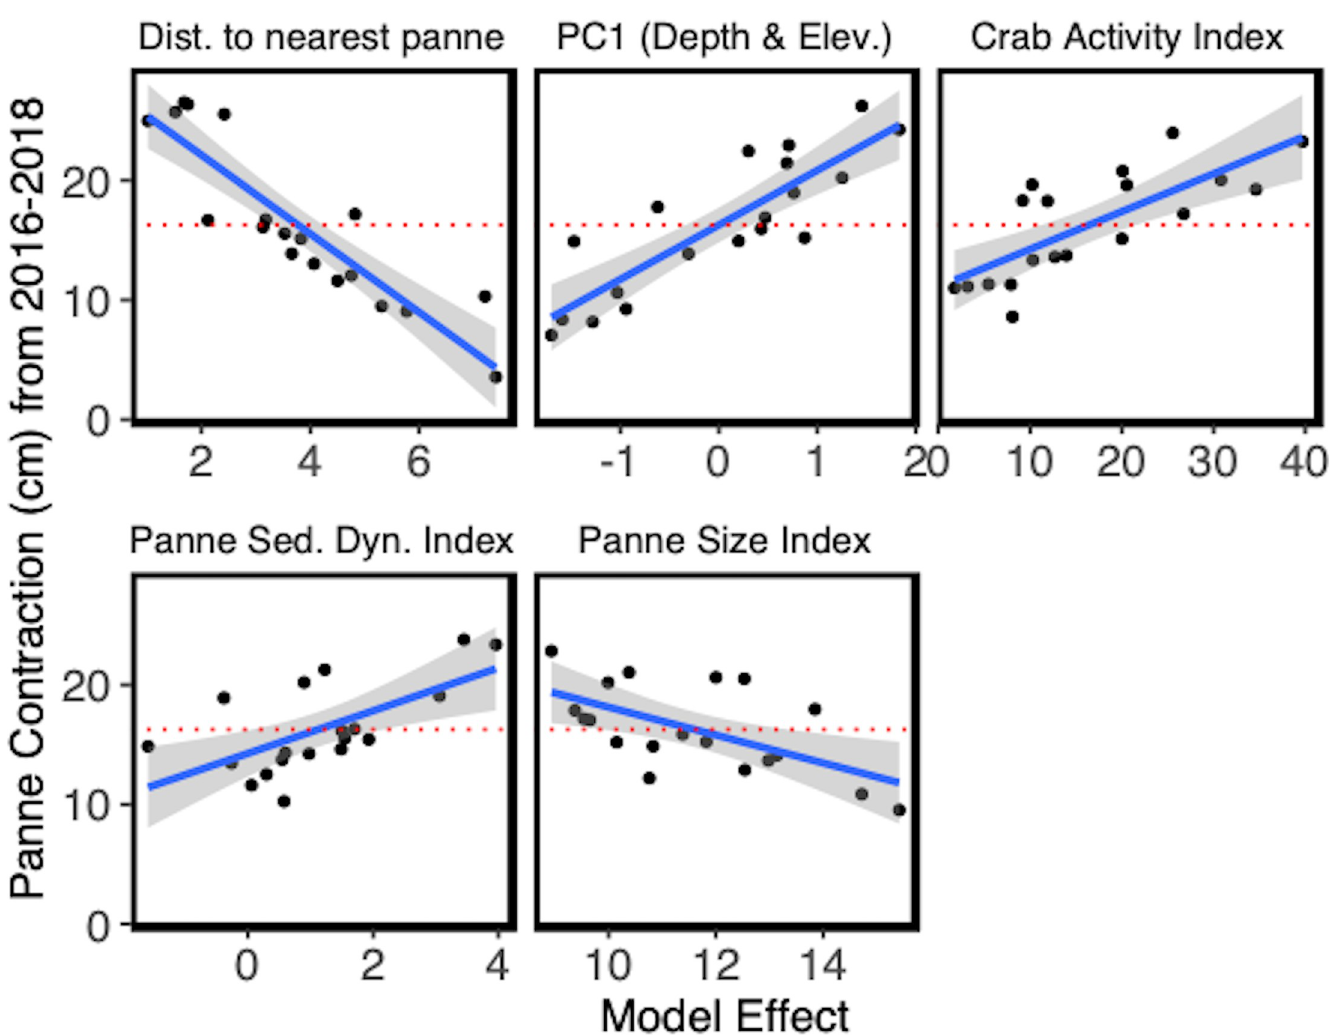
Fig 2. Partial leverage plots for all of the best-fit model effects. Plotted is the movement of marsh into the panne area (panne contraction along marsh-panne boundary) in cm. The dotted red horizontal line represents the average marsh-panne boundary movement from 2016–2018 of 16.298 cm. Each partial leverage plot includes the 95% C.I. For a list of the parameters included in the plotted indices, see Table